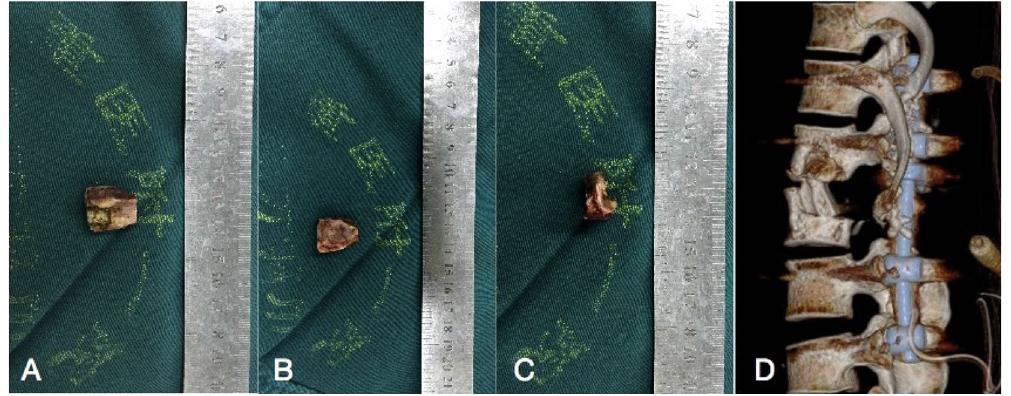
Figure 1. Photographs of one LSP before ( A – C ) and after implantation ( D